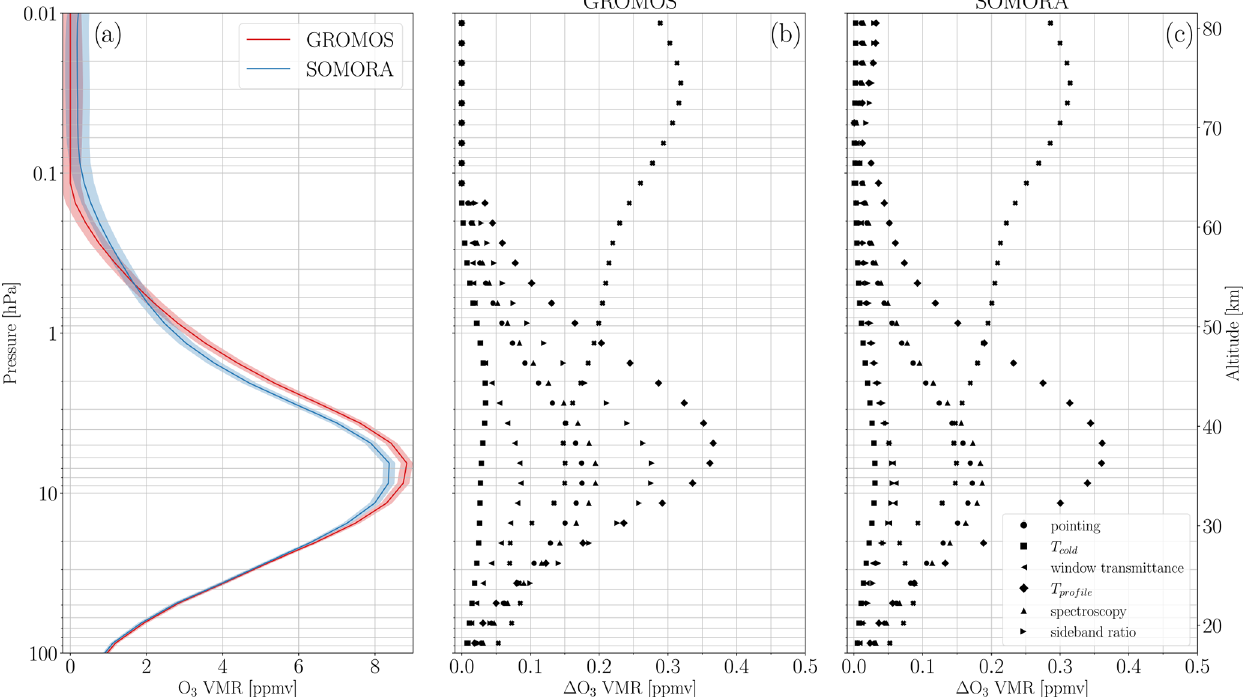
Figure B1. Uncertainty budget for GROMOS and SOMORA in the high-opacity case ( τ ≈ 1 . 3). Panel (a) shows the reference ozone profile chosen for the sensitivity analysis. Panels (b) and (c) show the ozone VMR uncertainties arising from the error sources listed in Table